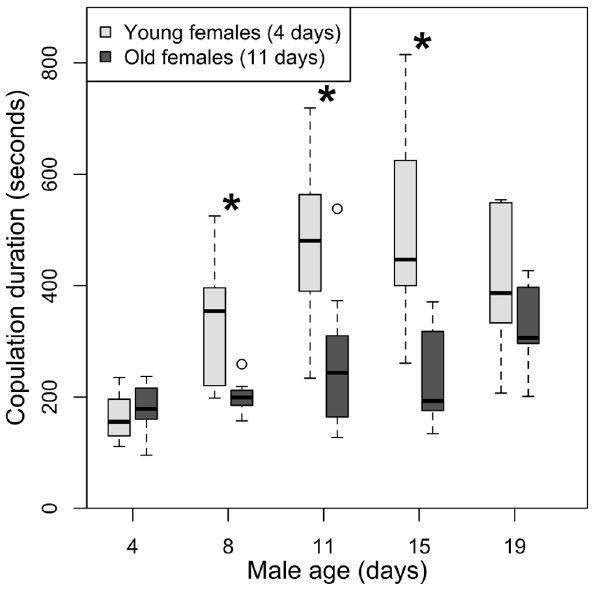
Figure 1. The effect of male age on copulation duration with young females (light grey boxes) and old females (dark grey boxes). Asterisks indicate significant differences in copulation duration between old and young females within a male age